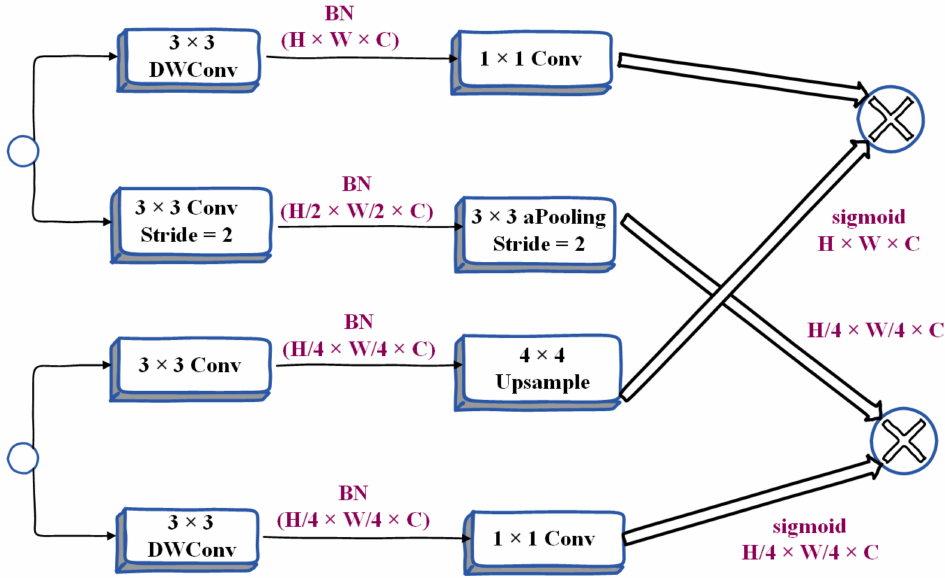
Figure 6. Detailed design of Bilateral Guided Aggregation